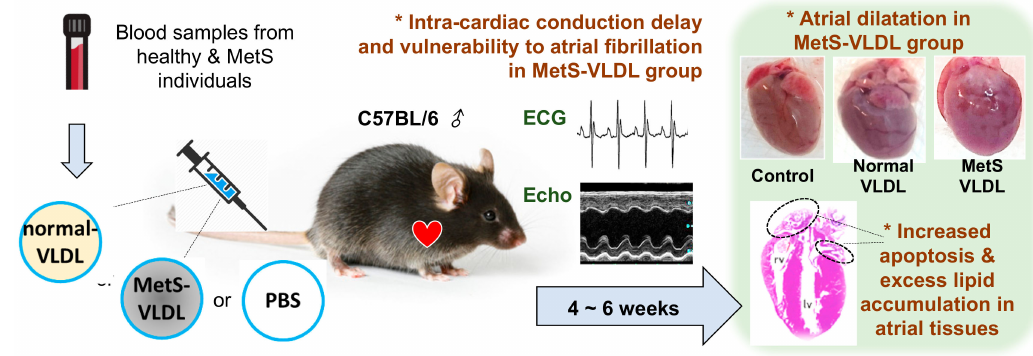
Figure 1. In vivo e ff ects of very low density lipoproteins (VLDLs) on atrial remodeling of C57BL / 6 male mice. Blood samples were collected from heathy volunteers and individuals with metabolic syndrome (MetS). Normal-VLDL and MetS-VLDL were isolated respectively. The VLDLs were injected via tail vein of the mouse three times a week for 6 consecutive weeks. The electrocardiography shows intra-cardiac conduction delay with significantly prolonged P waves and PR intervals in the MetS group. Upon isoproterenol challenge, some mice of the MetS group had atrial fibrillation whereas other groups did not. The echocardiography shows dilatation of left atria in the MetS group. In histological studies, MetS group were found to have increased lipid accumulation and increased myocyte apoptosis when compared with the control and normal-VLDL